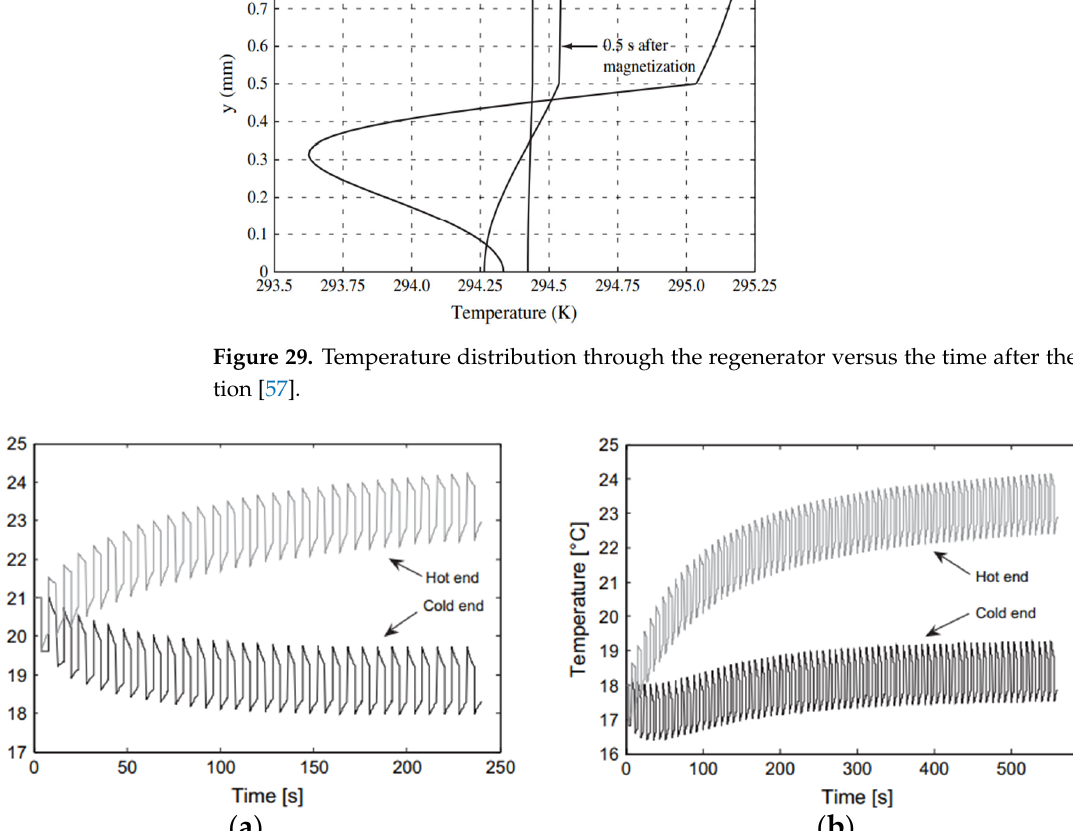
Figure 30. Simulation results ( a ) of the transient temperatures at hot and cold ends of the regenerator and ( b ) the temperature evolutions the same temperatures when starting at a lower temperature [55].